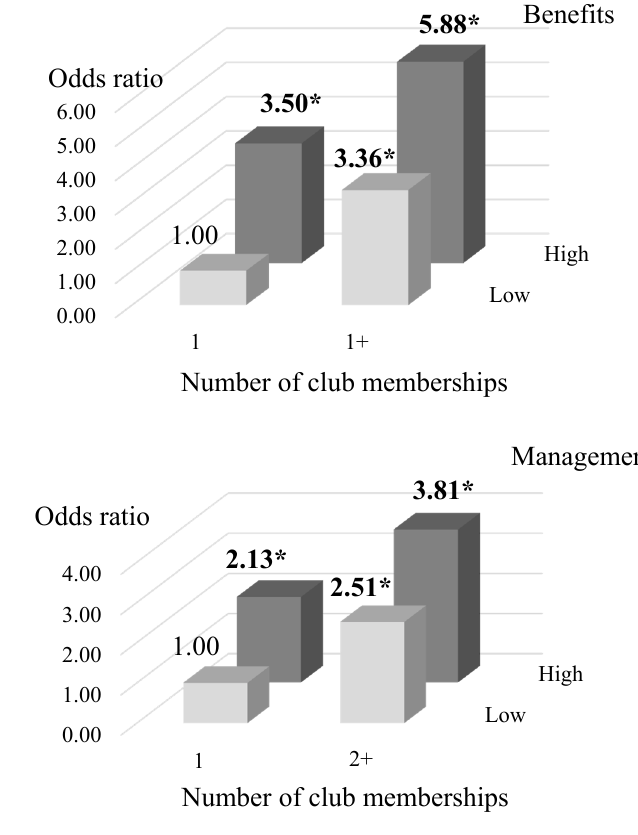
Figure 2. The association between sports service evaluation and healthy agers over 65. * p -value < 0.05.